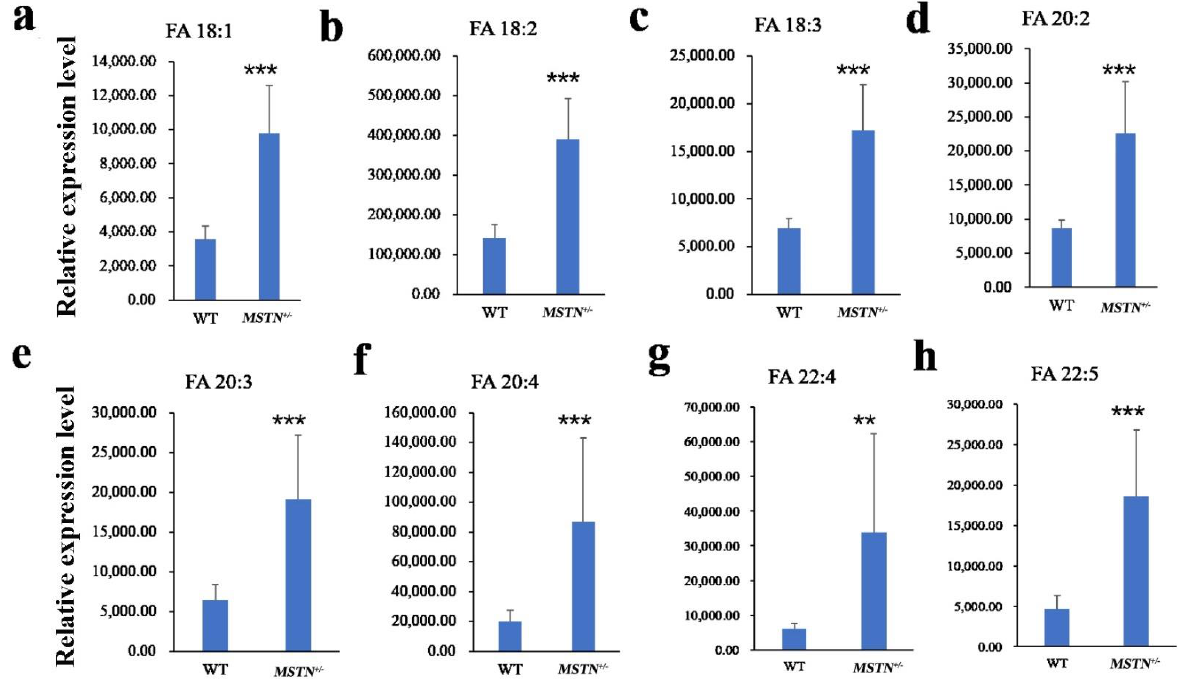
Figure 5. Differentially expressed long-chain unsaturated fatty acids in the MSTN +/ − versus the WT